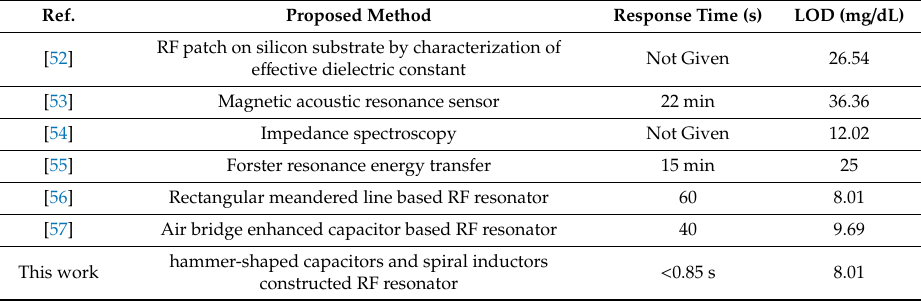
Table 3. Performance of the proposed glucose sensor compared with recently reported studies.